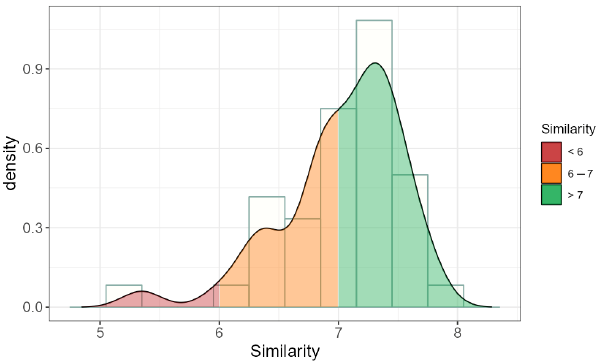
Figure 15. Reconstruction similarity. The x-axis is the reconstruction similarity and the y-axis is the data density. The higher the value, the more similar the two shapes are. The styling similarity between the orange and red areas was greater than 6, which means that the styling in this area was more than “relatively similar” to the original wheel hub.